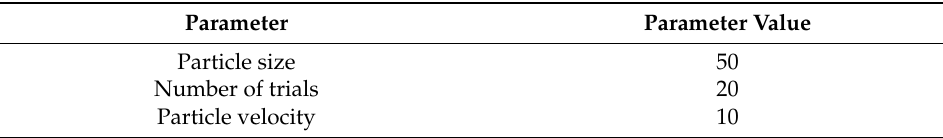
Table 6. List of PSO parameters used in Logic